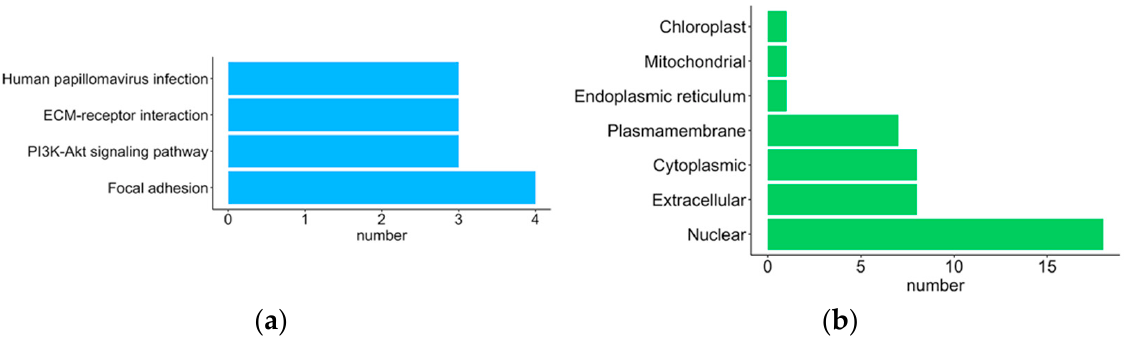
Figure 4. The KEGG pathways and predicted subcellular localization of the proteins encoded by selected signature genes of GBM. The lengths of the bars represent the number of proteins involved. ( a ) The KEGG pathways, which involve more than three proteins. ( b ) Predicted subcellular localization by CELLO2GO.